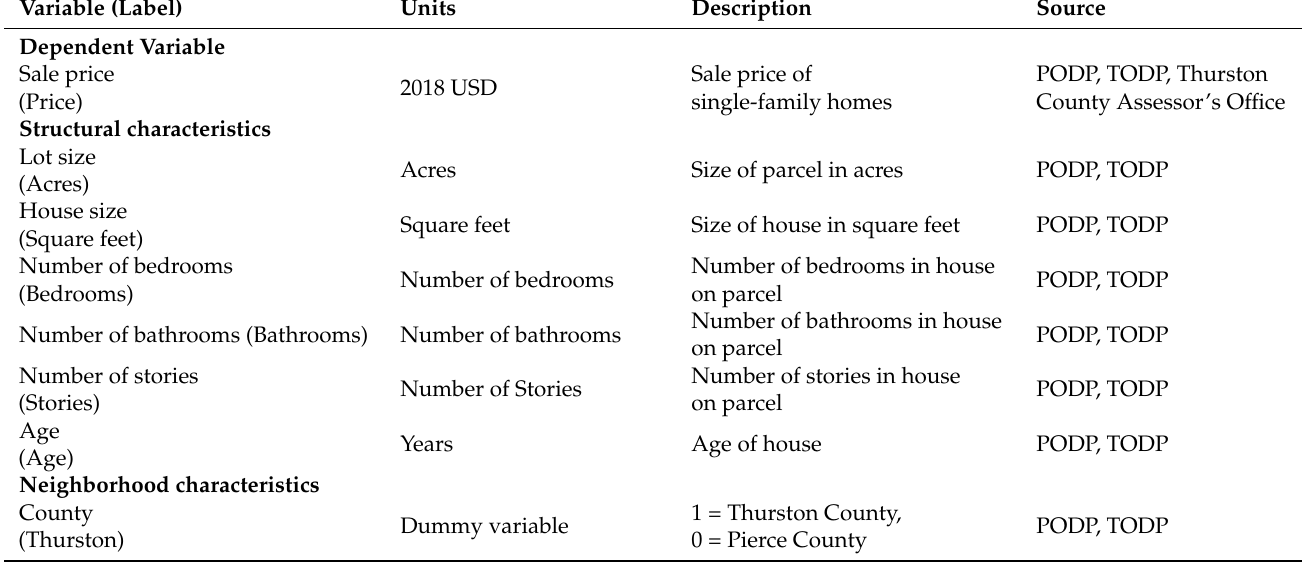
Table 1. Description of hedonic pricing model variables.